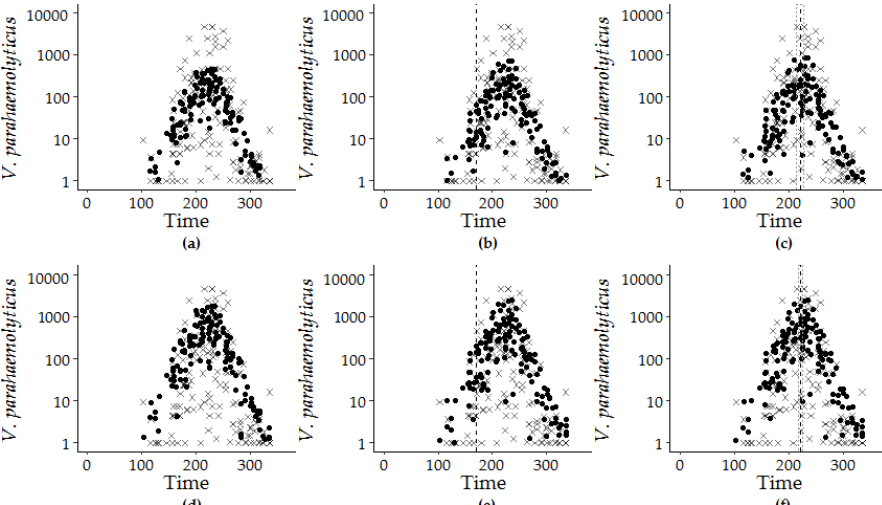
Figure 6. Model estimations (filled circle) and observed V. parahaemolyticus concentrations (x) are superimposed by the calendar day of the year from 2007 to 2016: GLM-G for ( a ) Model 7.4, ( b ) Model 8.1, and ( c ) Model 9.1 and GLM-NB for ( d ) Model 7.4, ( e ) Model 8.1, and ( f ) Model 9.1. The dashed vertical line at day 170 for the hybrid model ( b , e ) marks the longest day of the year, and the dashed lines at day 222 ± 5 days and at day 221 ± 7 days indicate the calculated peak timing of V. parahaemolyticus concentration for Model 7.1 for ( c ) GLM-G and ( f ) GLM-NB versions.